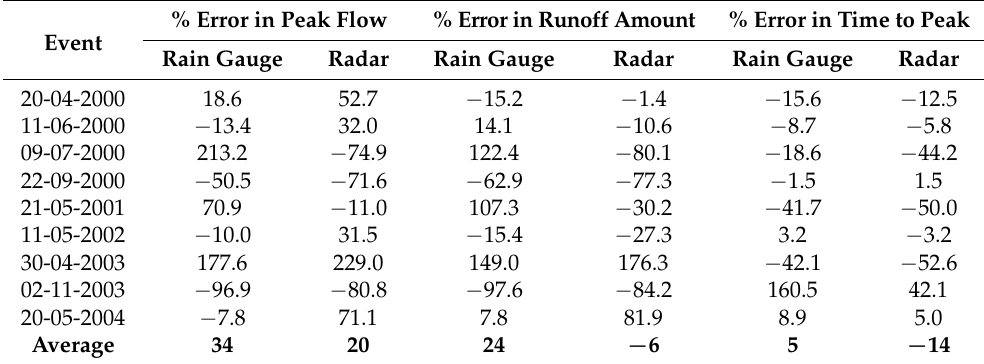
Table 7. Statistical comparison between observed and simulated peak flow rate, runoff amount, and time to peak using best estimated Green and Ampt model parameters.